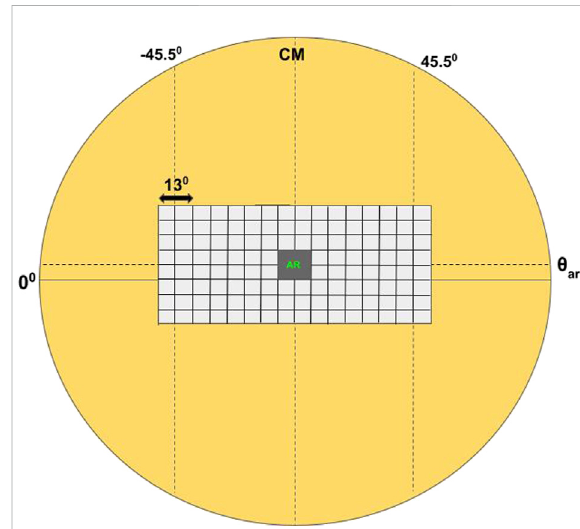
FIGURE 1 A cartoon representing the selection of patches for ring diagram analysis. The active region latitude is represented as θ ar . Each patch is of size 13 ° and there are 15 overlapping patches across longitude centered between ± 45.5 ° from the central meridian (CM). Corresponding to each longitude, there are seven overlapping patches across latitude with the middle patches centeredat θ ar .Thecartoonhererepresentsthepatchselectionon the fourth day of tracking, when the active region (grey shaded area) patch is along the central meridian. (Grid sizes are not up to scale).